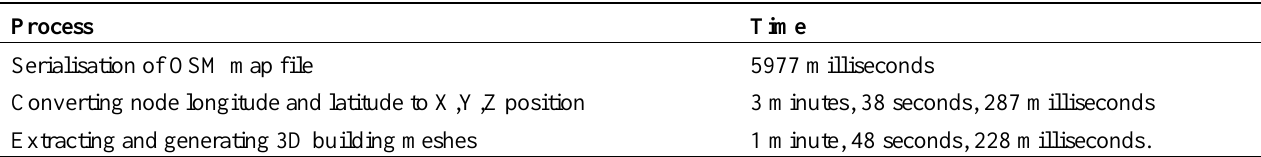
Table 2. OSM file parsing and generation for buildings within Manchester UK. Area coverage 115.6 km 2